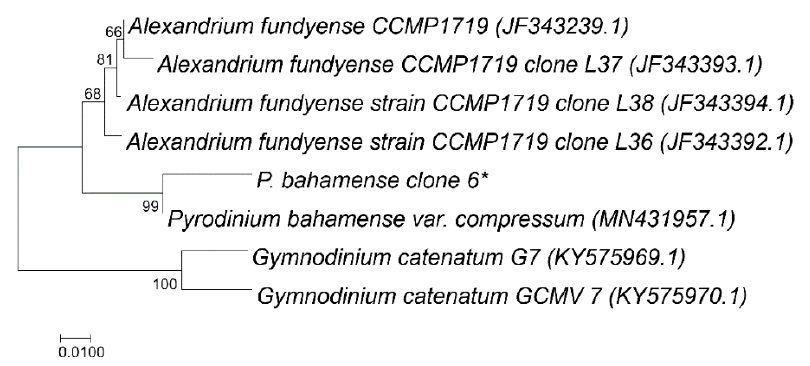
Figure 2. Neighbor Joining tree of sxtA4 sequences. Representative Alexandrium , Pyrodinium , and Gymnodinium sxtA4 sequences were downloaded from GenBank and aligned and trimmed in MEGA 7. Percentages from the bootstrap test (500 replicates) are displayed next to the branches. The rate variation among sites was modeled with a gamma distribution (shape parameter = 0.32). The analysis encompassed 8 nucleotide sequences. All positions containing gaps and missing data were eliminated. There were a total of 575 positions in the final dataset. Evolutionary analyses were conducted in MEGA7. * indicates P. bahamense sxtA4 sequence from this study.